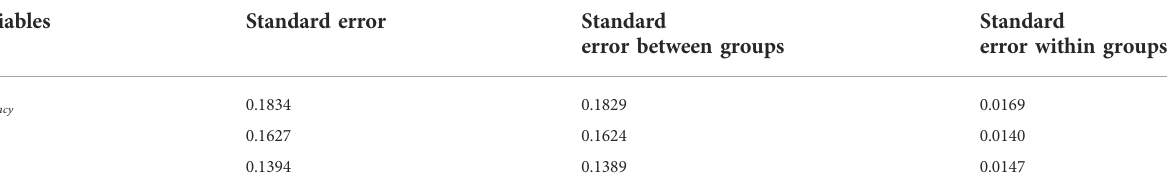
TABLE 3 Descriptive statistics of urban spatial structure indexes.